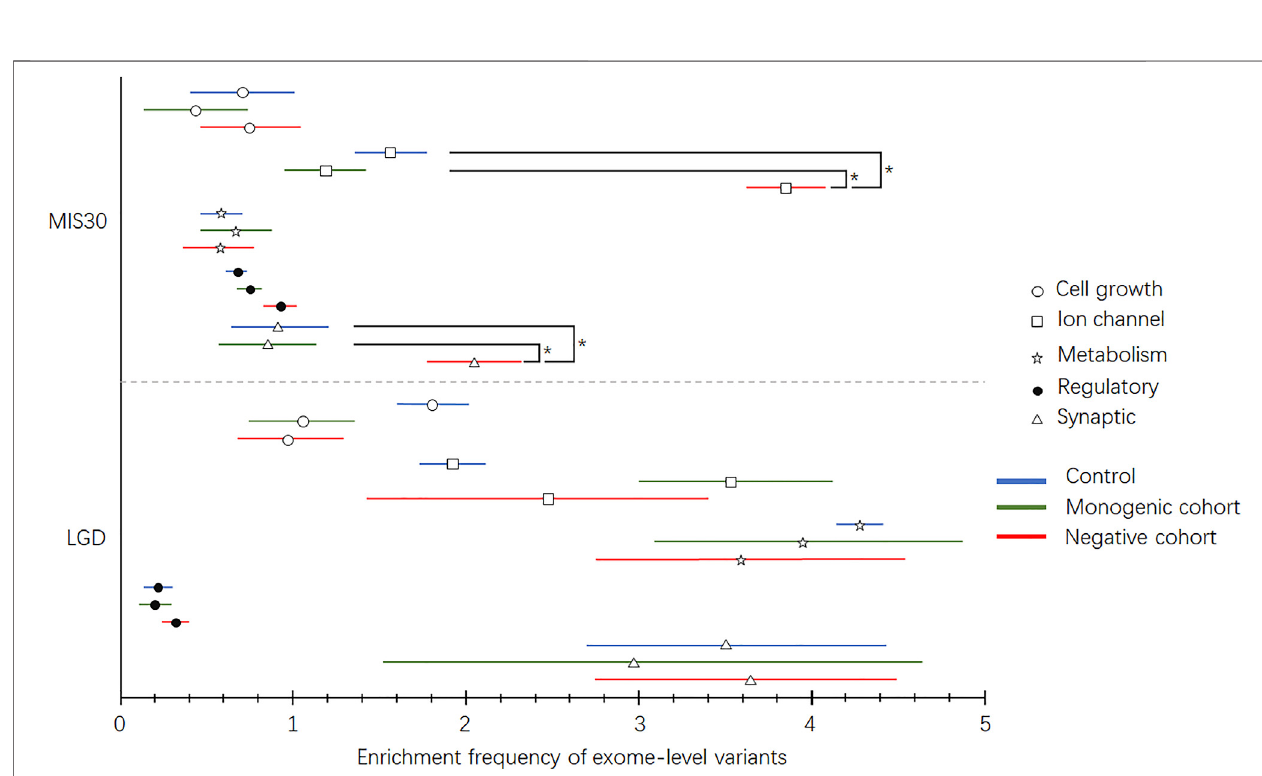
FIGURE 3 | Enrichment frequency of exome MIS30 and LGD variants in different functional categories. MIS30 variants ’ enrichment in patients with a negative monogenic diagnosis is signi fi cantly higher than that in the control and monogenic